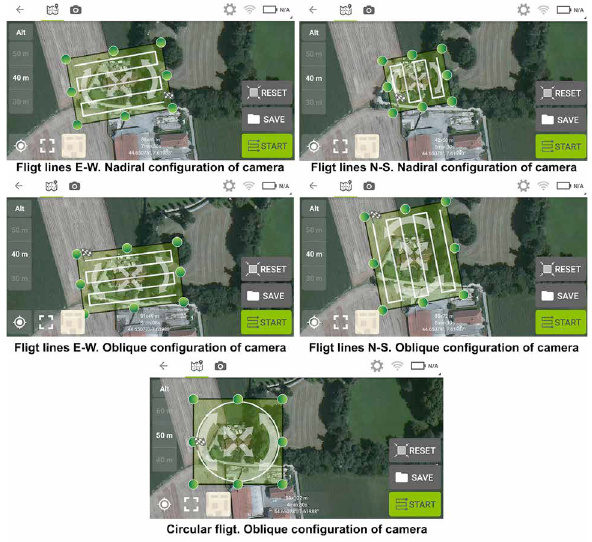
Figure 6. Flight planning using Pix 4D